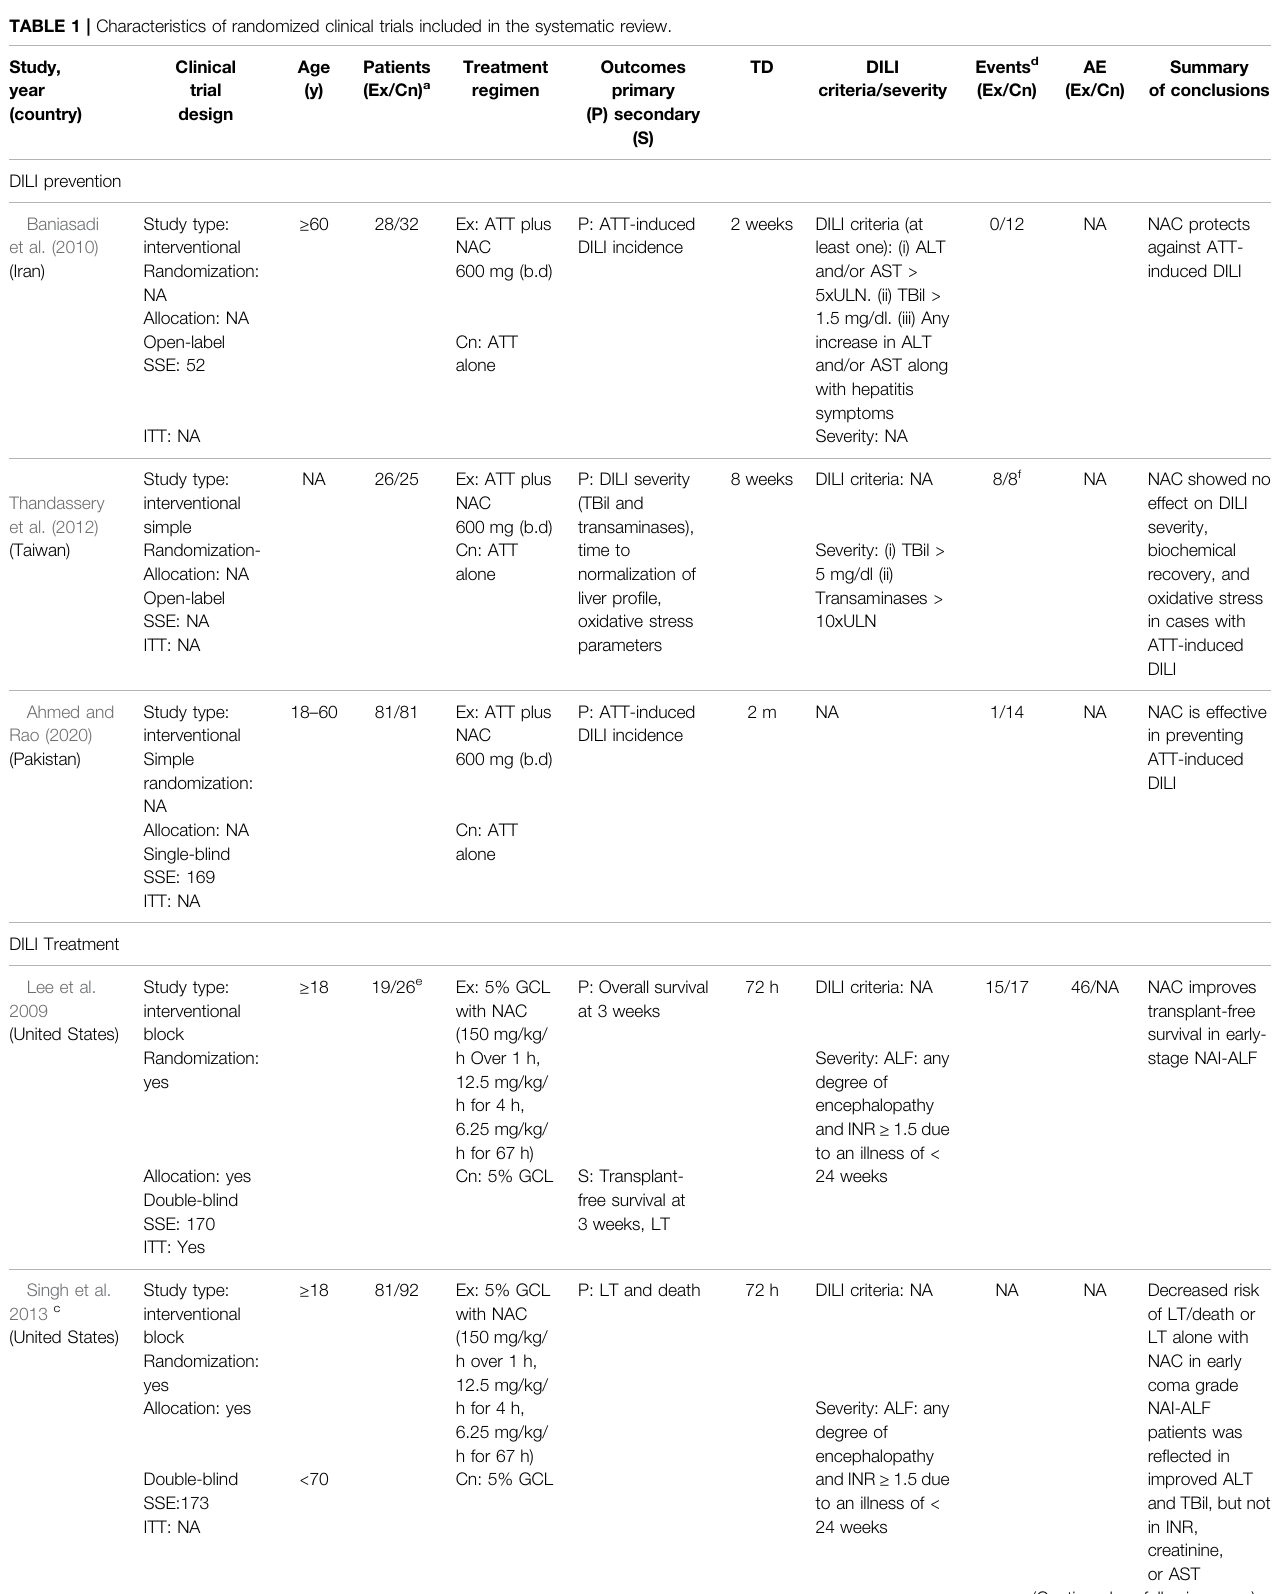
TABLE 1 | Characteristics of randomized clinical trials included in the systematic